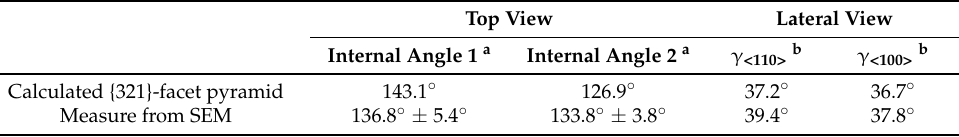
Figure 5. Top view and lateral view SEMs of microneedles. Table 2. Angles from different view.